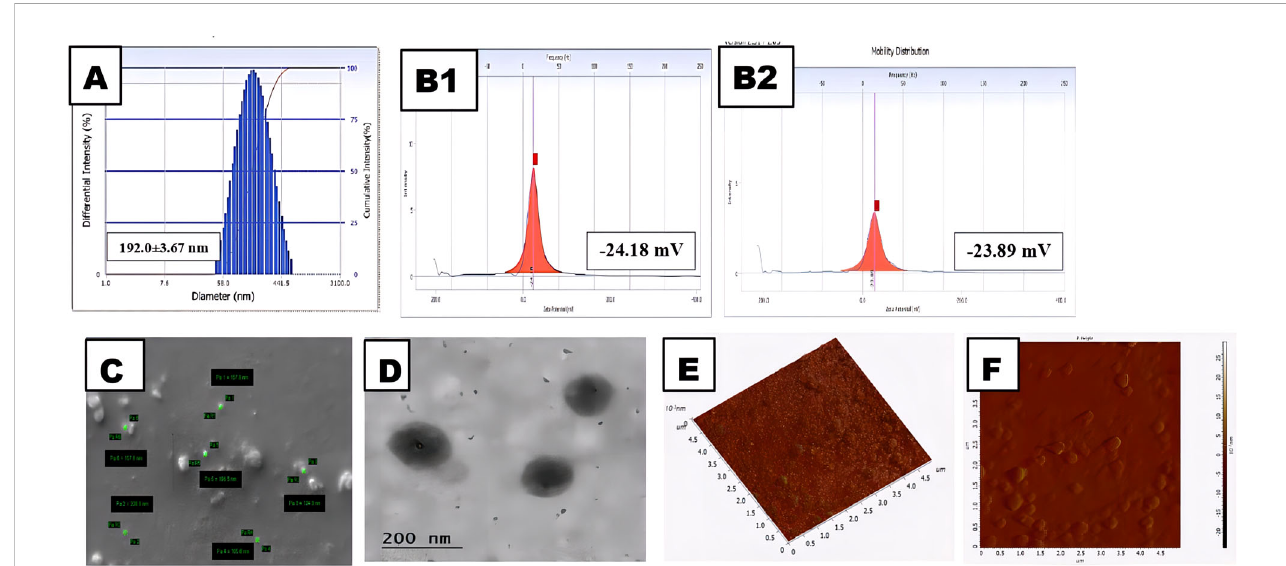
FIGURE 1 Physical characterization of the CNB-PLGA-PSar-NPs: (A) Size of the NPs. (B1) Zeta potential of the NPs in water; (B2) Zeta potential of the NPs in Phosphate buffer solution (pH 7.4). (C) Field emission scanning electron microscopy (FE-SEM) images of the NPs. (D) Transmission electron microscopy (TEM) of the NPs (E) Atomic force microscopy image of NPs in 3D (F) Atomic force microscopy image of NPs in